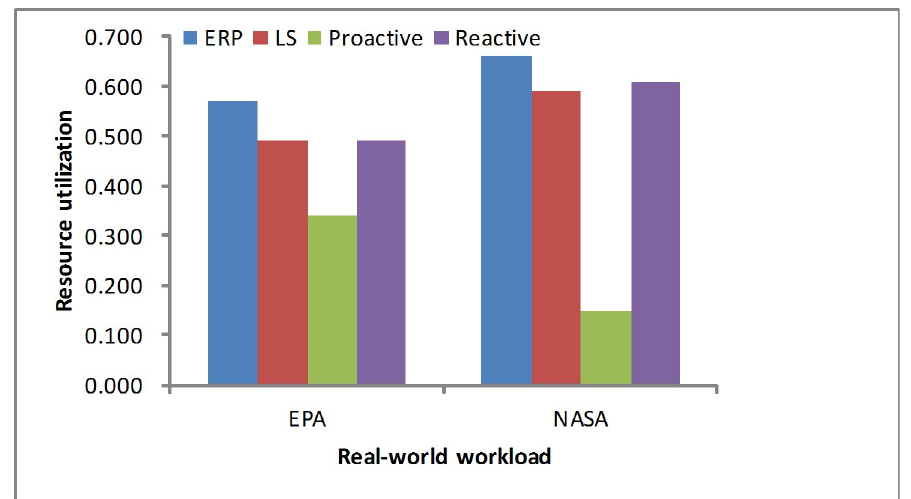
Fig 11. Average resource utilization in the real-world workloads.